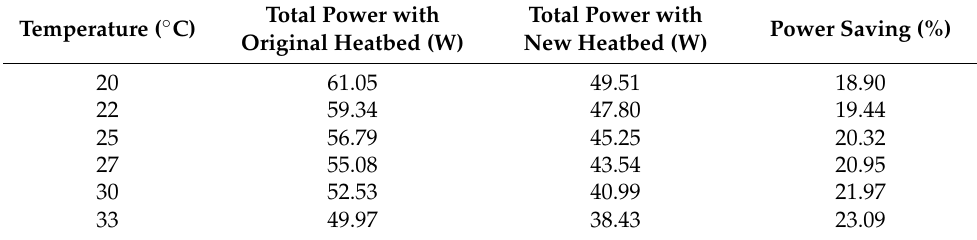
Figure 12. Controlling mechanism for new heatbed. Table 3. Results of the proposed strategy were measured by